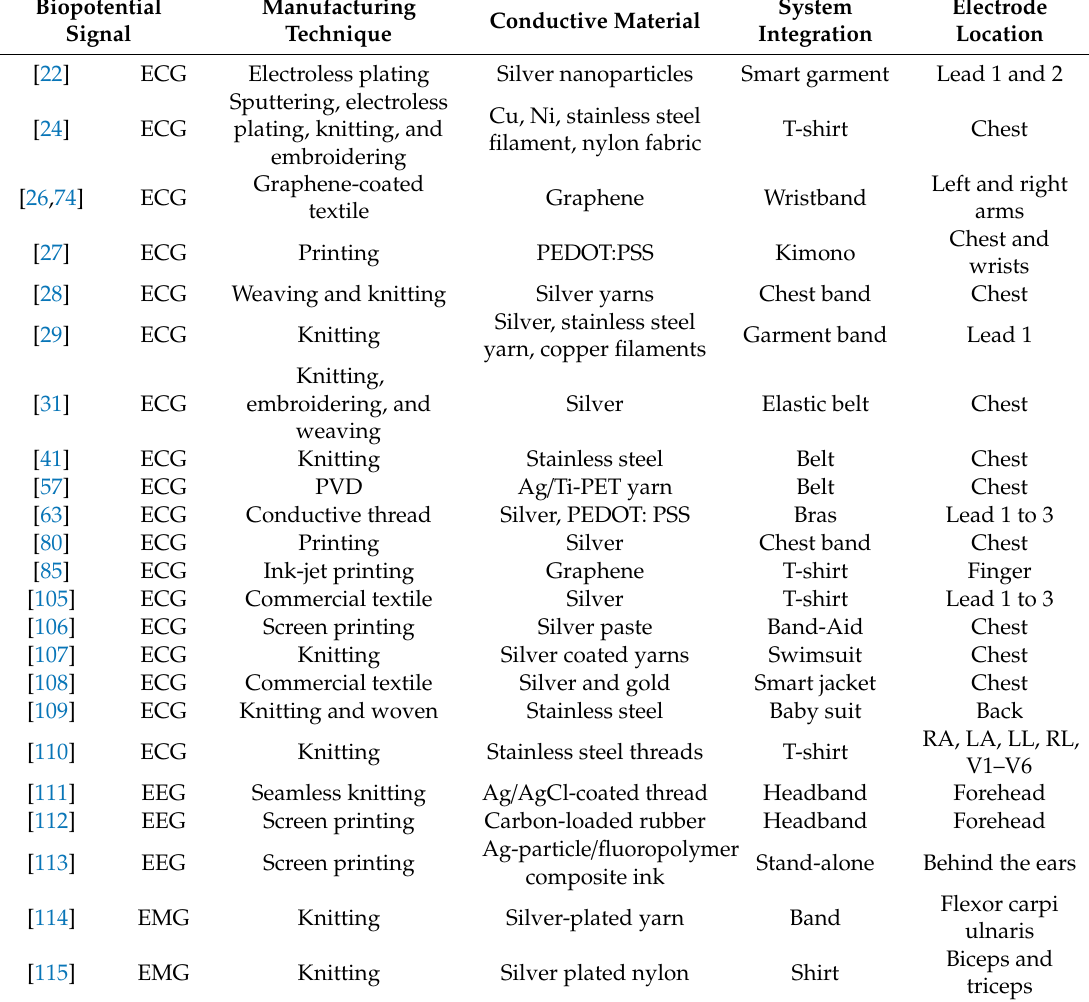
Table 1. Summary of the various integrated textile system solutions categorized based on the acquired biopotentials to show the di ff erent manufacturing techniques and conductive materials used in their realization and the active sensing regions on the body.